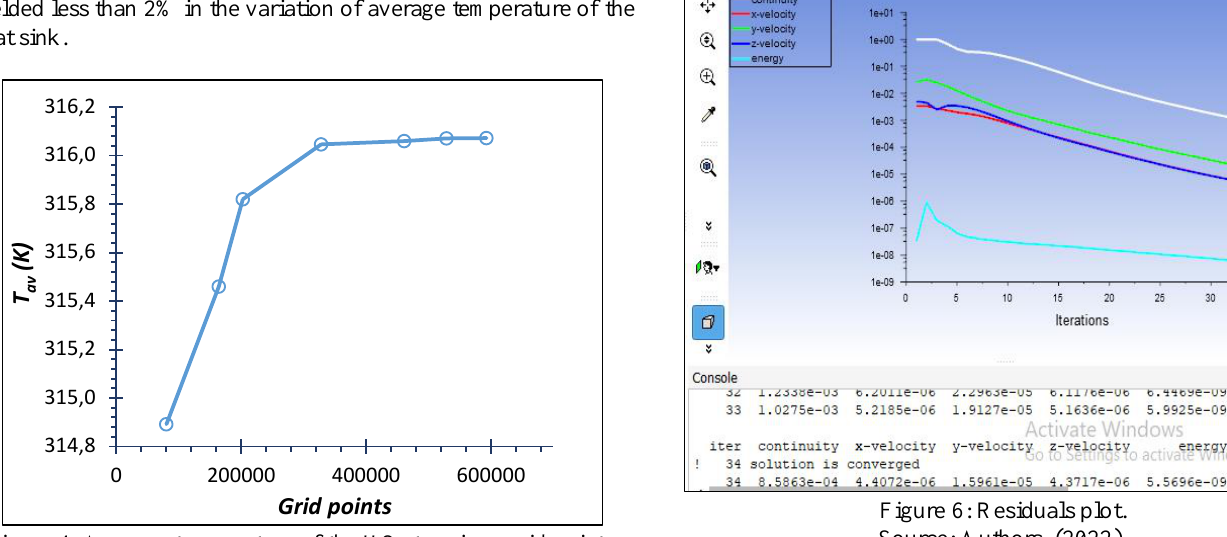
Figure 4: Average temperature of the HS at various grid points.